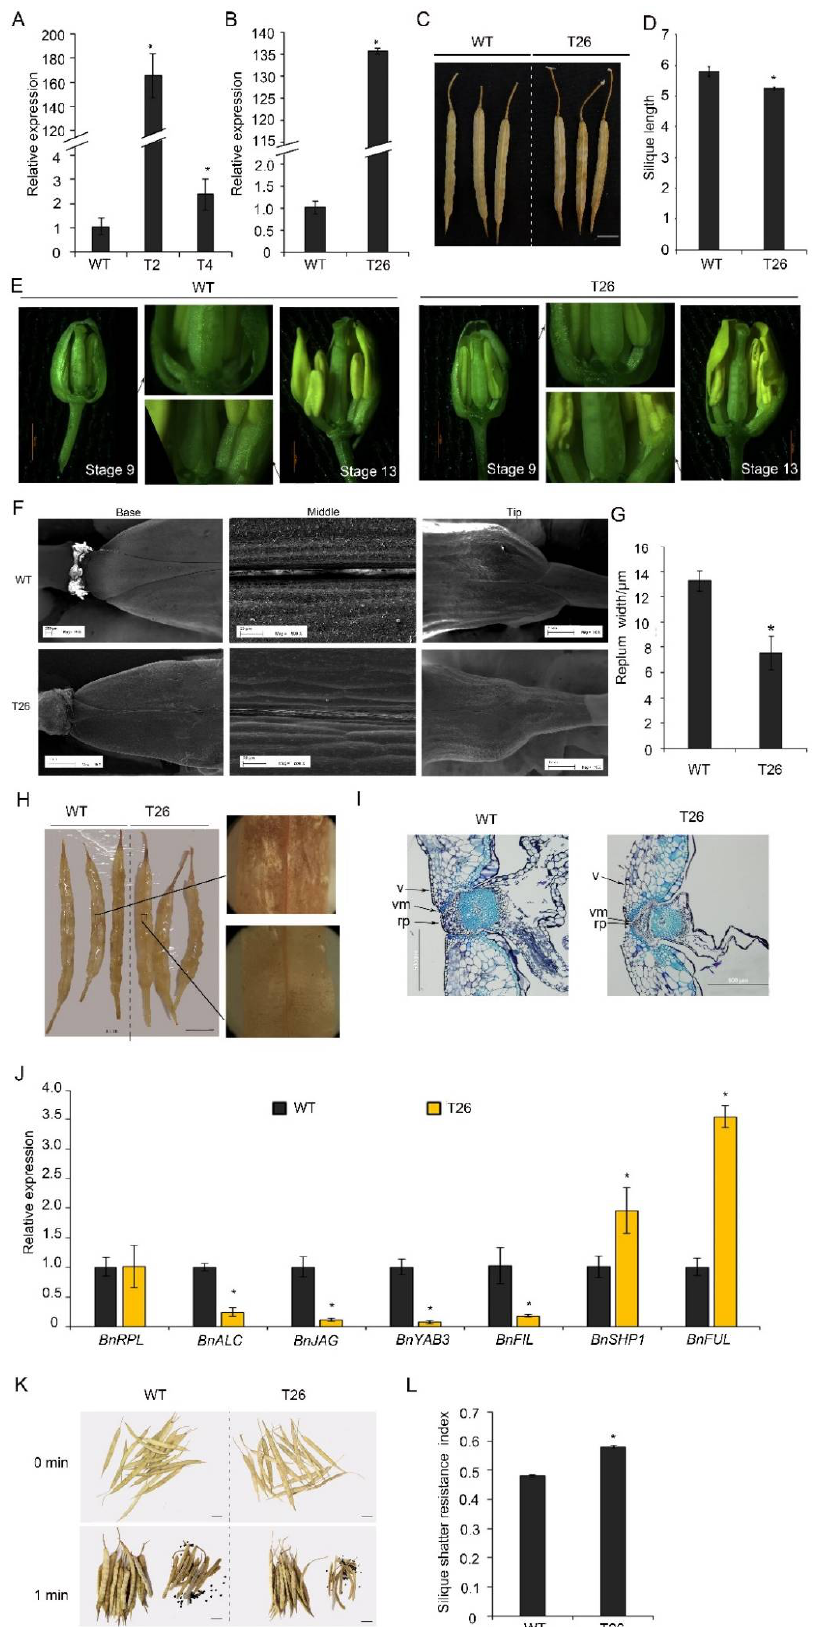
Figure 6. Silique shattering in rapeseed plants overexpressing BnTCP3.A8 . ( A ) Real-time PCR